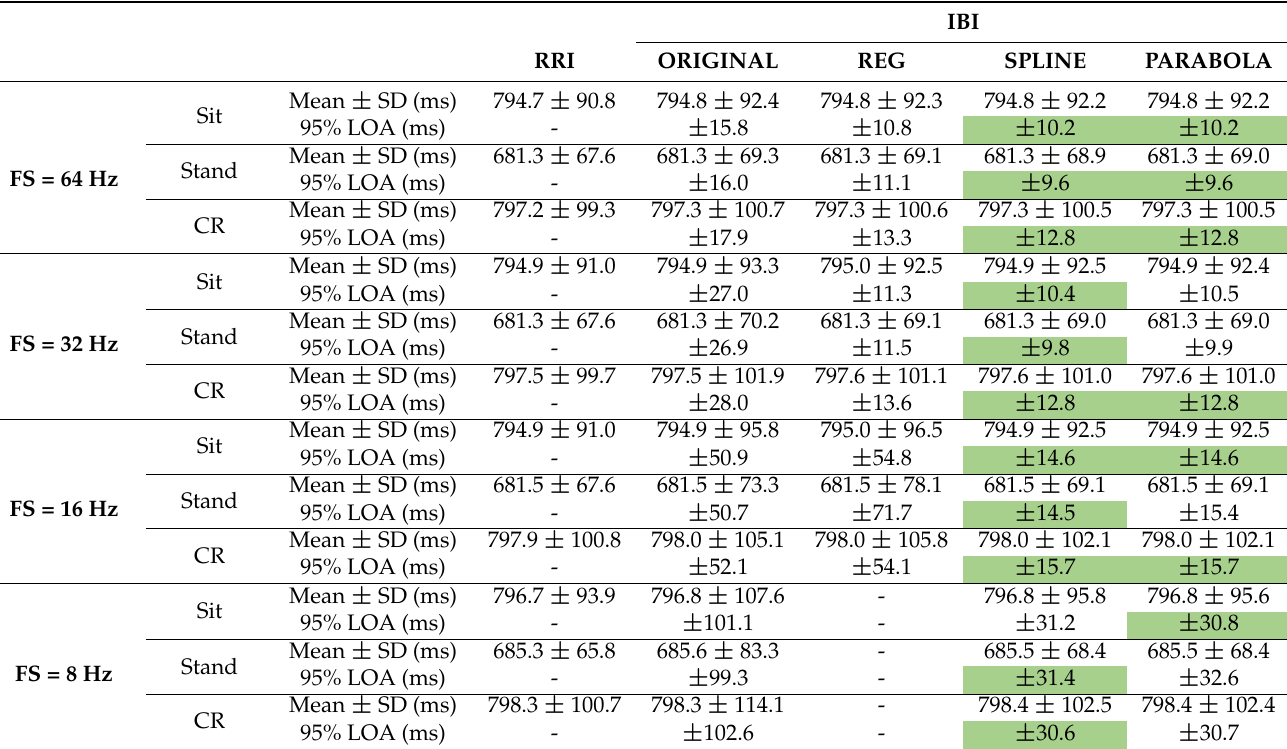
Table 4. Mean and standard deviation of the RRIs and of the IBIs directly computed after beat detection (ORIGINAL) or refined through REG, SPLINE, and PARABOLA approaches; 95% LOA computed between the RRIs and each series of IBIs. The best performances in terms of 95% LOA are highlighted (green) for each sampling rate and protocol phase. The REG method was not appliable at 8 Hz. IBI RRI ORIGINAL REG SPLINE